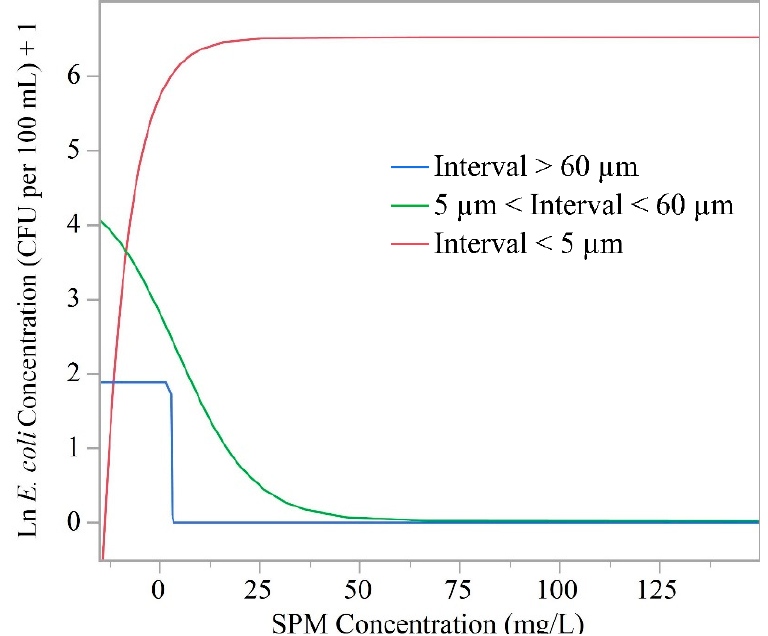
Figure 7. Ln of E. coli concentration (CFU per 100 mL) relative to SPM in three filtration size intervals (<5 µm; 5 µm < interval < 60 µm; >60 µm), at four monitoring sites during study period (20 July 2018–27 October 2018) in West Run Watershed, West Virginia, USA. Note all E. coli concentration values are +1 to avoid ln values being undefined where E. coli concentrations were zero. Additionally, interval size was dictated by the filer sizes (5 µm and 60 µm) that we used during the filtration of the extracted water samples.